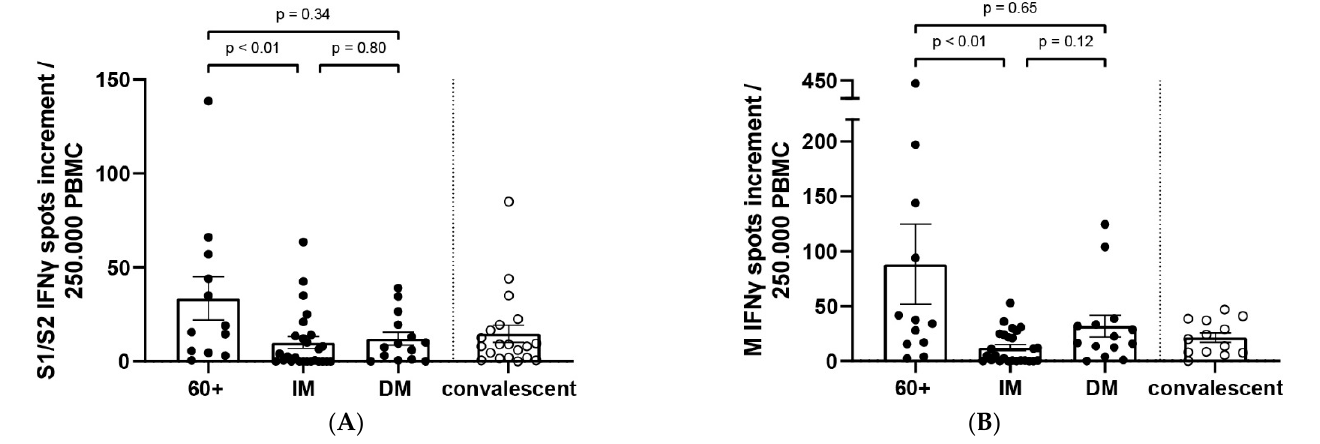
Figure 3. T-cell responses of elderly (60+), immunocompromised (IM) and diabetes mellitus (DM) patients compared to a convalescent cohort: S1/S2-protein-specific T-cell responses ( A ) and M protein specific T-cell responses ( B ) for 51 patients and 20 convalescent was determined via ELISpot assay. Each dot ( • ) represents one patient and each hollow dot ( ) represents one convalescent. Comparison between the groups was performed with the Mann–Whitney test. Statistical significance was set at the level of p < 0.05.